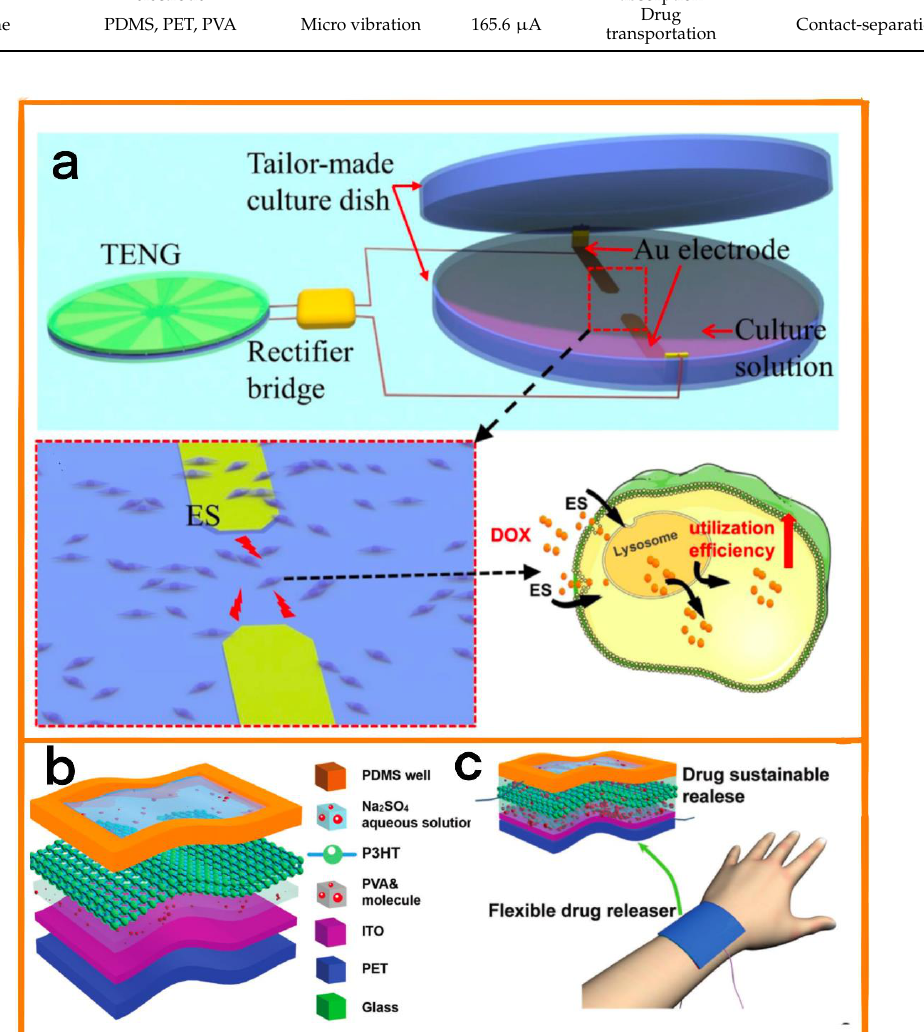
Figure 13. ( a ) Diagram of the equipment and schematic diagram of the co-culture of cells and DOX after electrical stimulation. Reprinted with permission from [94]. 2022, Frontiers. ( b ) Structural diagram of this TENG. ( c ) Schematic diagram of the sustainable release of salicylic acid. Reprinted with permission from [95]. 2020, John Wiley and Sons. Liu et al. also designed a self-powered drug delivery device (FDRD) [95]. The device integrated three TENG units, each consisting of multi-layer flexible structures (Figure 13b) that effectively collect disordered biological energy from the environment, providing elec- trical power for the device. At the same time, the device monitors the flow of small mole- cules (such as salicylic acid, which has exfoliating, bactericidal, and anti-inflammatory ef- fects) out of the FDRD in real time (Figure 13c), and provides vital data support for the long-term personalized treatment of patients by recording and analyzing the flow rate of small molecules. 5. Conclusions and Perspectives In the current paper, recent advances in TENG-based medical equipment for the di- agnosis and long-term treatment of disease have been concisely introduced, and the cor- responding design strategies, including design concepts, operation principles, and the problems and solutions of the designs, have been described in detail. For better